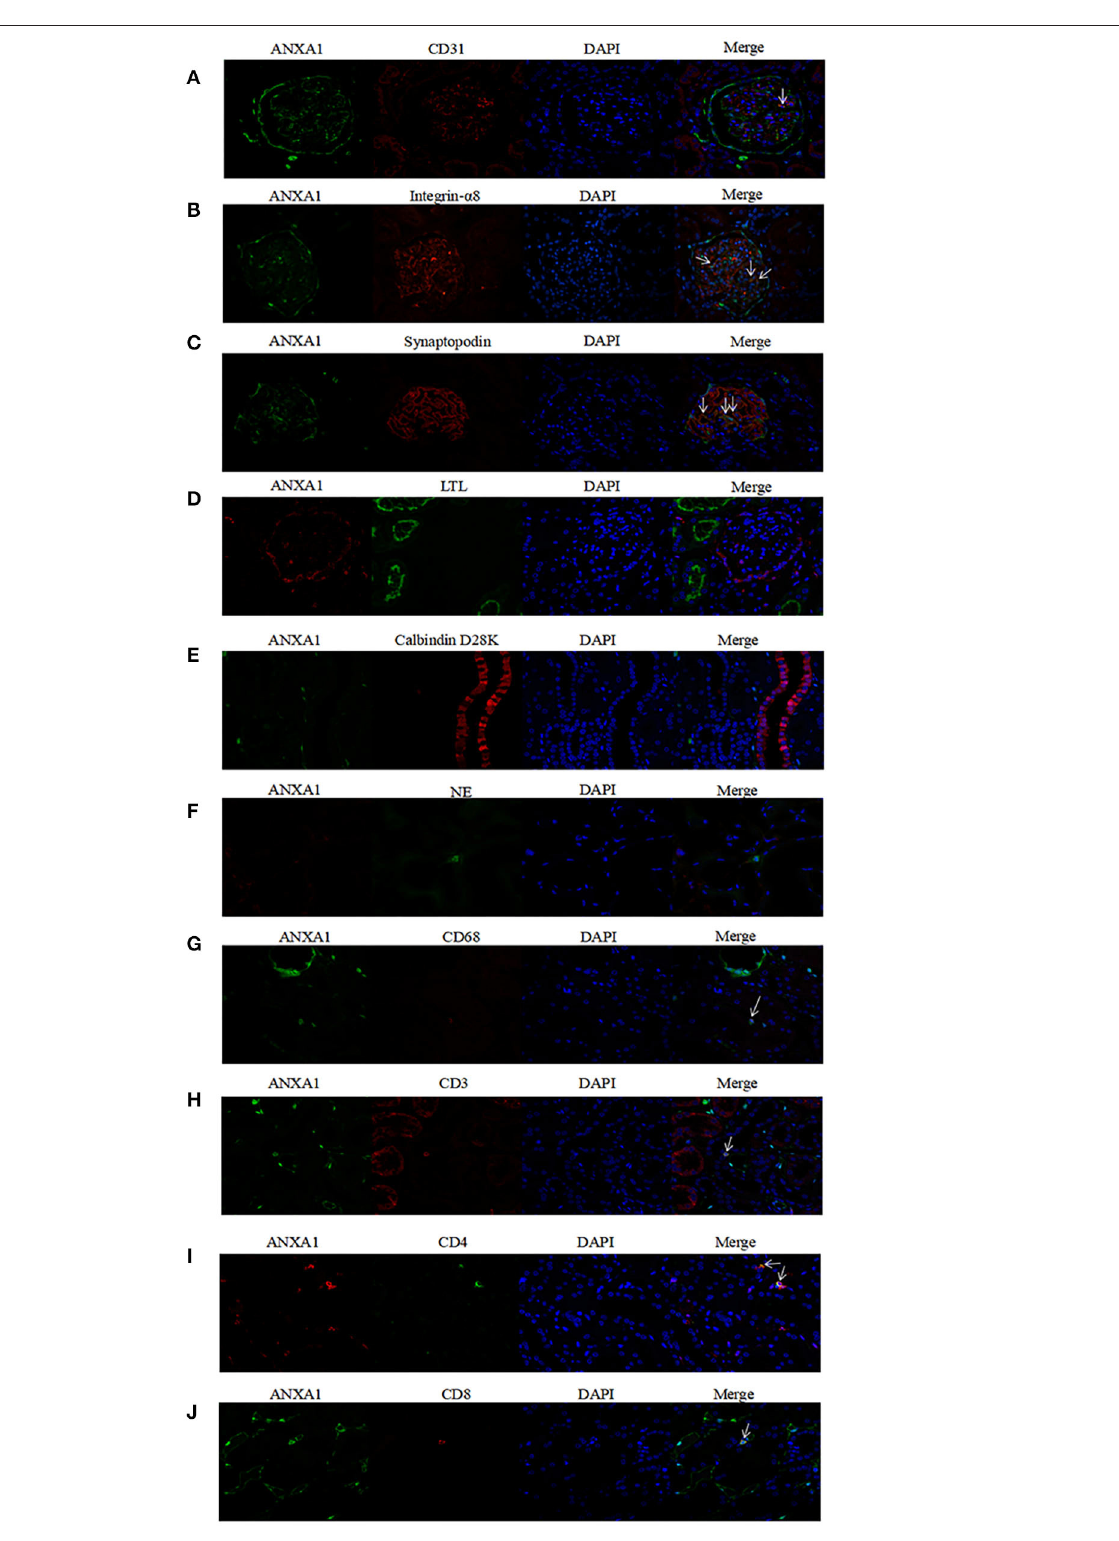
Frontiers in Medicine |